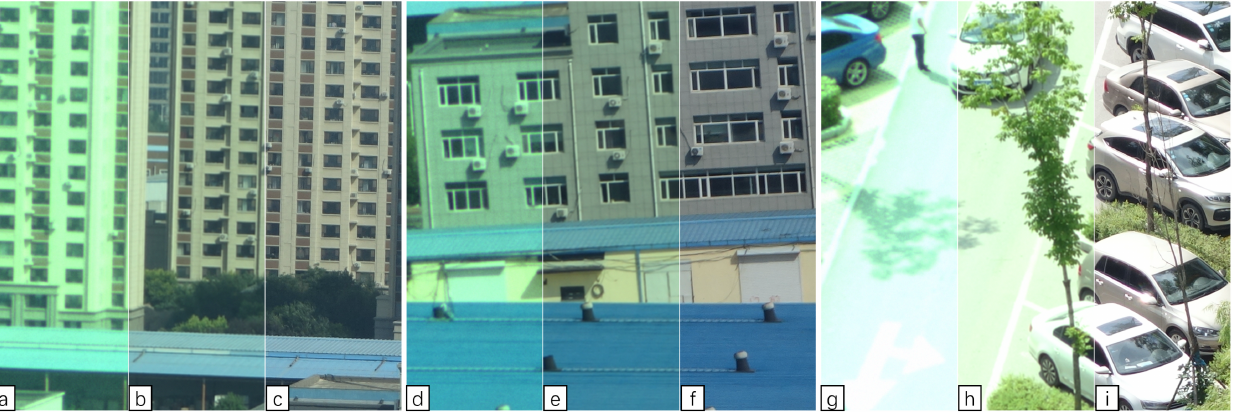
Figure 8. ( a , d , g ) are the original images captured by the sensor; ( b , e , h ) are the images after process- ing when the multimodal objective function was replaced by the standard cross-entropy function; ( c , f , i ) are the results of normal processing by the DDZMR network model.